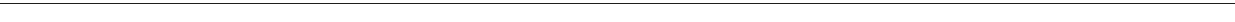
Fig. 1 Phenotype of fetuses, fetal weight, and size during maternal ZIKV infection in Ifnar1 − / − mice with or without depletion of CD8 + , CD4 + , or both CD4 + and CD8 + T cells. Non-immune and DENV2-immune Ifnar1 − / − dams that were administered isotype control Ab (Isotype), anti-CD4 Ab (Anti-CD4), anti-CD8 Ab (Anti-CD8), or both Abs (Anti-CD4 + CD8) were inoculated via a retro-orbital route (RO) at embryonic day 7.5 (E7.5) with 10 4 FFU of ZIKV FSS13025 or 10% FBS – PBS as Mock. To generate DENV2-immune mice, mice were inoculated via an intraperitoneal route (IP) with 10 3 FFU of DENV2 strain S221 for 30 days prior to mating. a – d Fetal body weight ( a , c ) and size ( b , d ) were measured at E14.5. e , f Representative pictures from uterus, fetus, and placenta at E14.5 from ZIKV-infected non-immune or DENV2-immune dams with (right) or without (center) anti-CD8 Ab administration ( e ) or dams treated with anti-CD4 (center) or anti-CD4 + CD8 Ab (right) administration ( f ). Magenta arrows indicate the presence of fetuses having undergone resorption. n = 38 fetuses from fi ve separate mothers (non-immune-Mock), n = 34 fetuses from four separate mothers (non- immune-ZIKV + isotype), n = 43 fetuses from fi ve separate mothers (non-immune-ZIKV + Anti-CD8), n = 15 fetuses from three separate mothers (DENV2-immune-Mock), n = 22 fetuses from three separate mothers (DENV2-immune-ZIKV + isotype), n = 25 fetuses from three separate mothers (DENV2-immune-ZIKV + Anti-CD8), n = 26 fetuses from four separate mothers (non-immune-ZIKV + Anti-CD4), n = 36 fetuses from four separate mothers (non-immune-ZIKV + Anti-CD4 + CD8), n = 35 fetuses from four separate mothers (DENV2-immune-ZIKV + Anti-CD4), and n = 38 fetuses from fi ve separate mothers (DENV2-immune-ZIKV + Anti-CD4 + CD8). Weight and size were determined individually on the residual placenta if fetal resorption was observed. Data were pooled from two independent experiments. Kruskal – Wallis test was used, and data are expressed as median. * p < 0.05, *** p < 0.001, **** p <